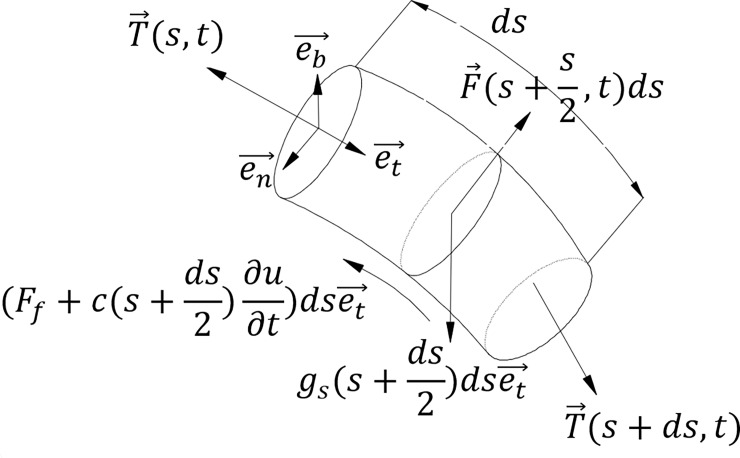
Forces of drill-string micro-element.https://dx.doi.org/10.17504/protocols.io.ke2ctge.